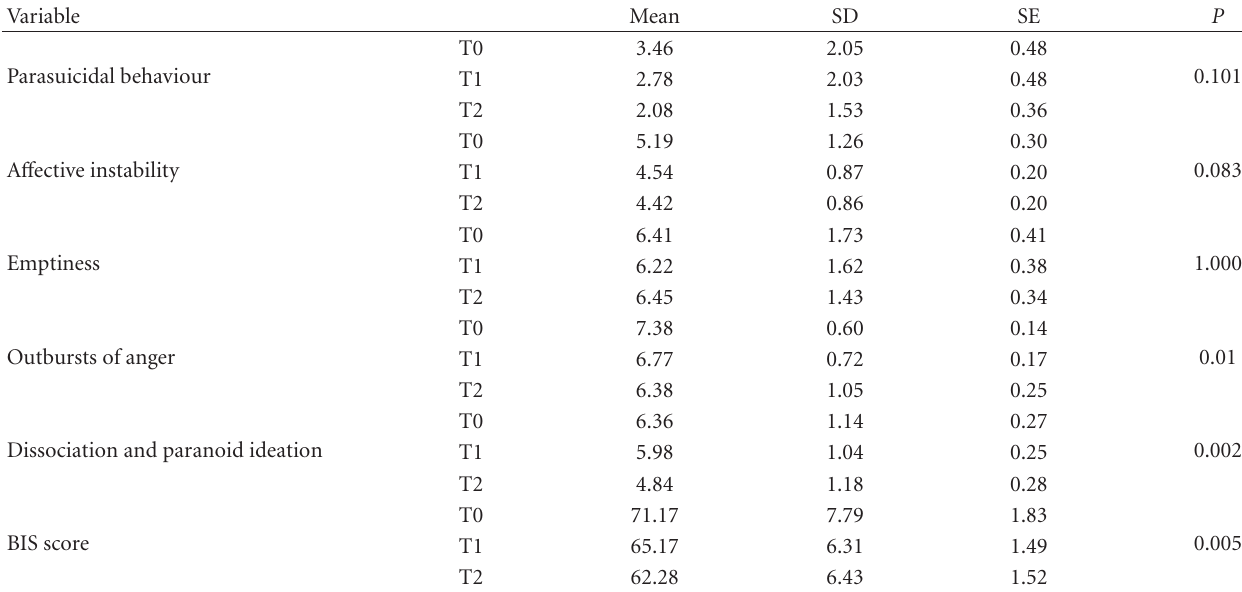
Table 3: Results of analysis of variance (ANOVA) for repeated measures with Bonferroni correction for multiple comparisons, performed with BPDSI items “parasuicidal behaviour,” “a ff ective instability,” “emptiness,” “outbursts of anger,” and “dissociation and paranoid ideation” and with BIS-11